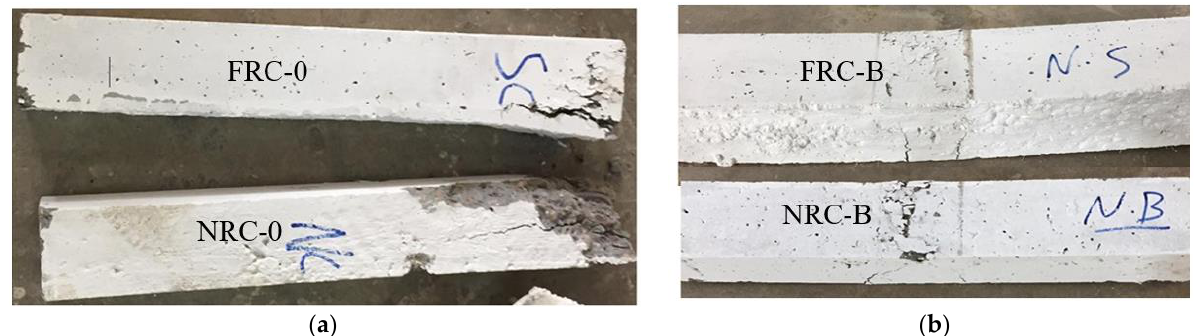
Figure 7. Failure mode of NRC and FRC ( a ) columns and ( b ) beams.